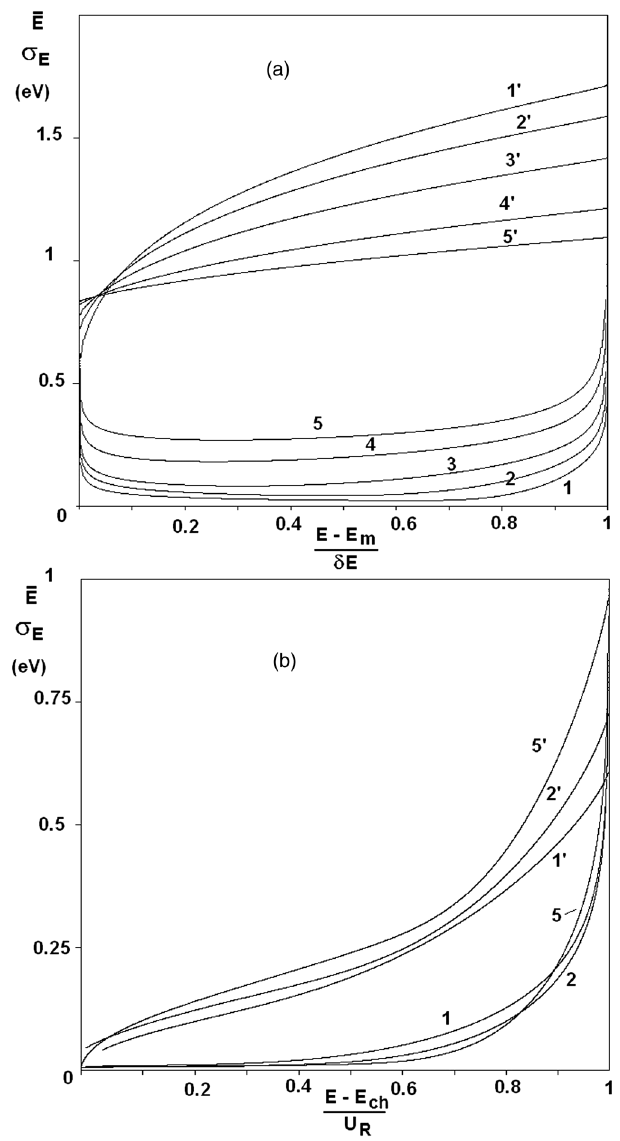
¯ E and σ E [in the (110) =U R , ch Þ ¯ E -quantities. Analo- ¯ E in (b) are enlarged